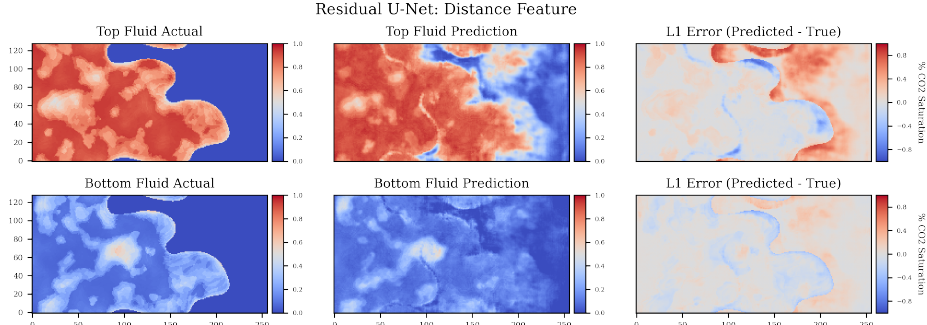
Figure 10. Residual U-Net with periodic padding in the x -direction and an additional distance feature concatenated to the input. The network performs better with positional information, such as the periodic characteristics of the domain and a sense of distance from the inlet of the fracture. However, the CO 2 front is poorly defined and there is substantial noise in the brine.